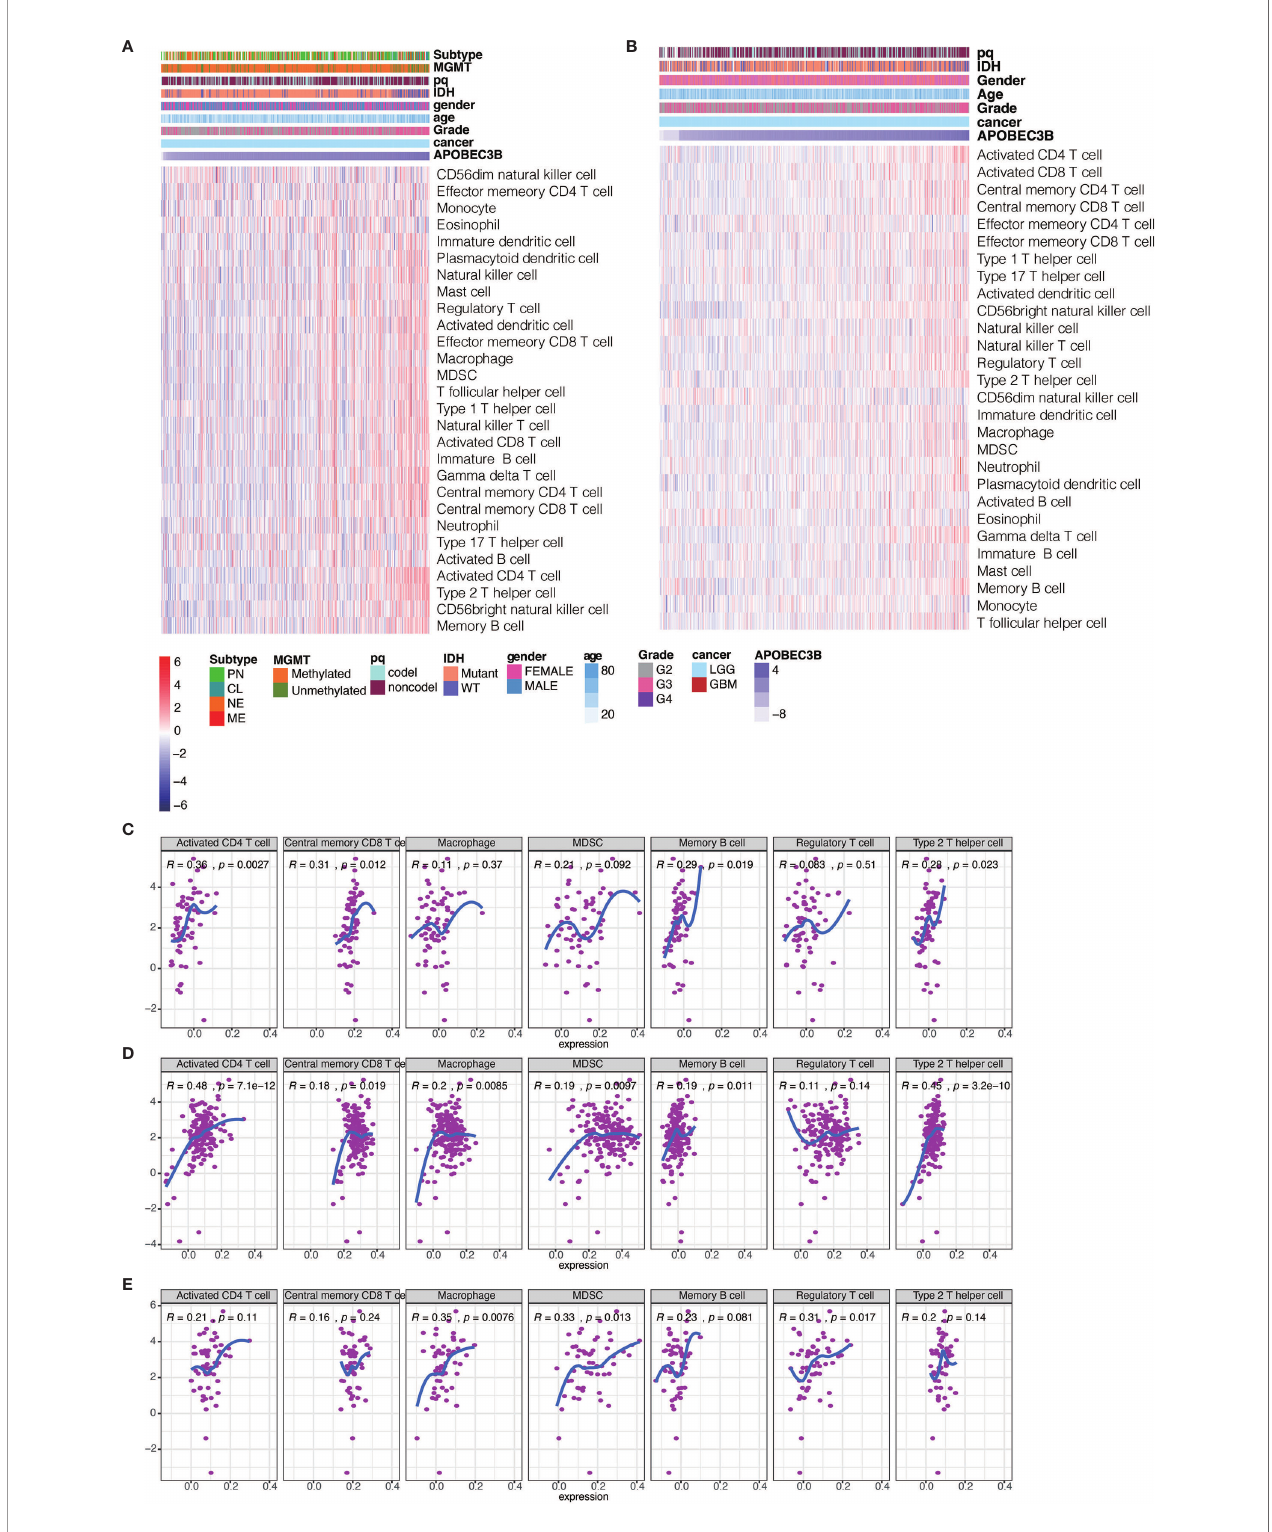
FIGURE 7 | Heatmaps illustrating the relationship between APOBEC3B and immune cell populations based on (A) TCGA and (B) CGGA in LGG patients. Correlation of APOBEC3B expression with immune in fi ltration cells including activated CD4+T cells, central memory CD8+T cells, macrophages, MDSC, memory B cell, regulatory T cells and Th2 cells in (C) KICH, (D) PAAD< (E)